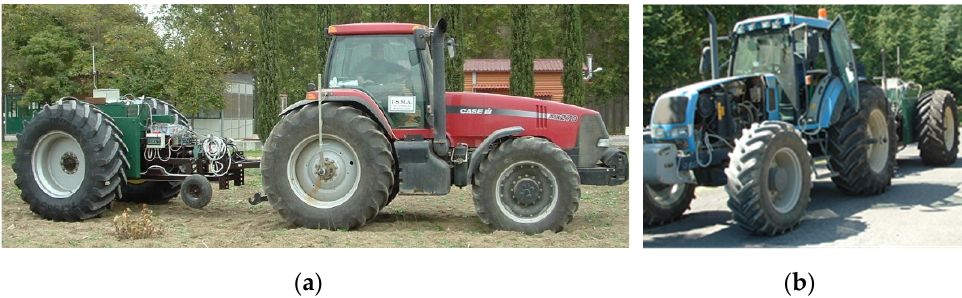
Figure 3. The MTB during the tests: ( a ) MTB on the compact surface with plant residue, pulled by a 205 kW tractor; ( b ) MTB and 4WD tractor with identical rear tires on asphalt track. 205 kW tractor; ( b ) MTB and 4WD tractor with identical rear tires on asphalt